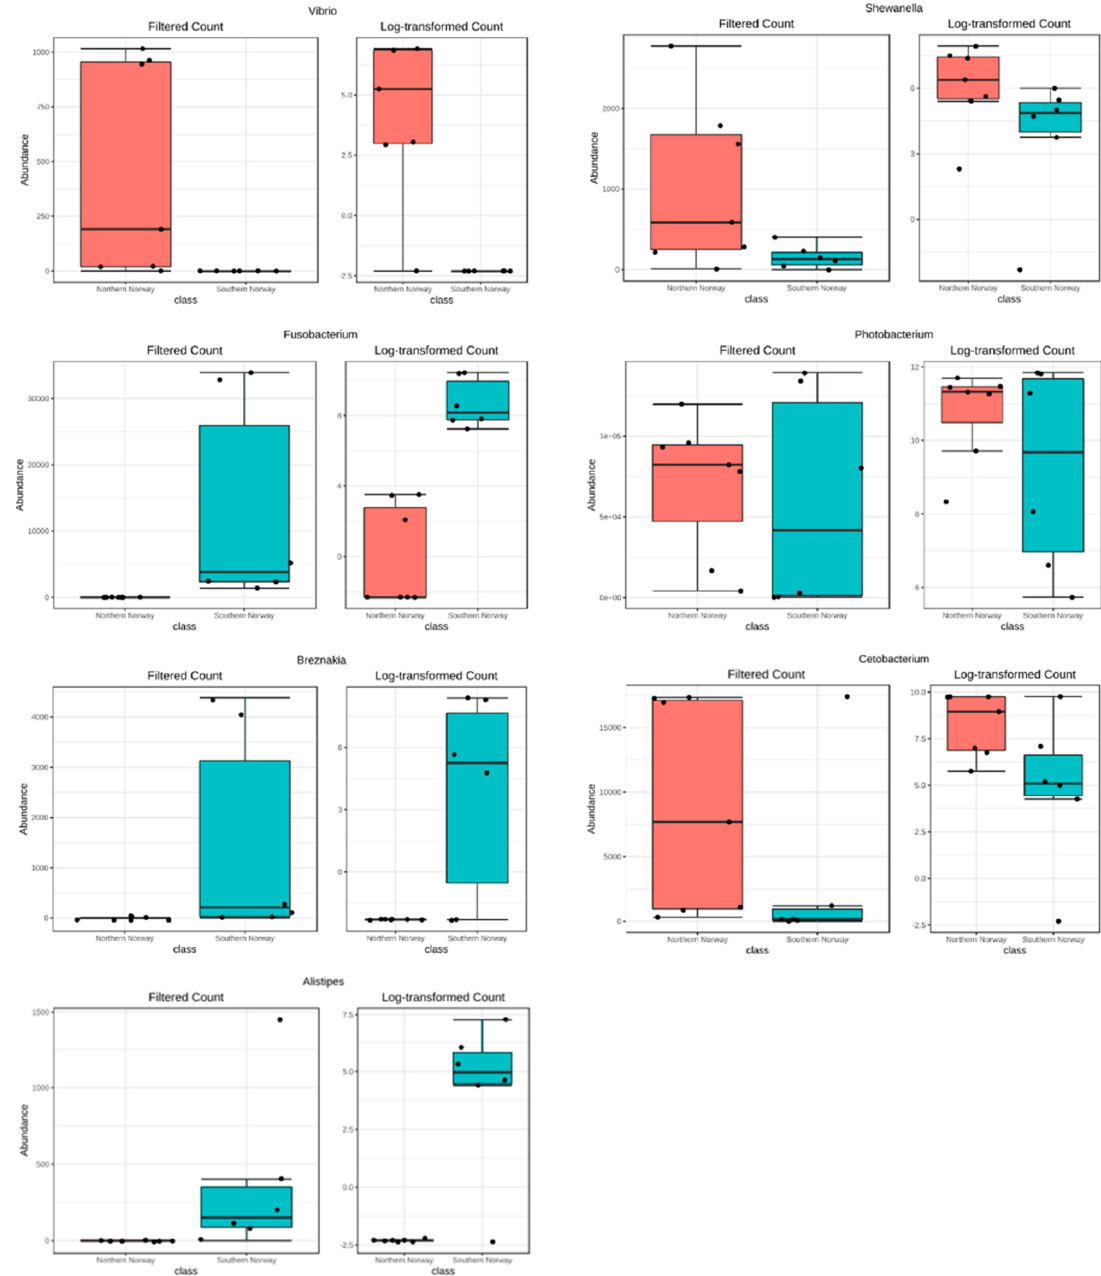
Figure 3. Differential abundance of bacteria in Atlantic cod gut samples from northern and southern Norway. Wald tests of log2 fold differential abundances of amplicon sequence variants (ASVs). Sixteen genera revealed significant features, based on p values, with differential abundance.